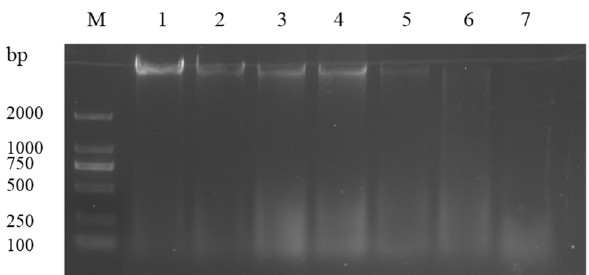
Figure 5. DNA cleavage activity of S. aureus ATCC 13565 strains after treating with ATCE at 1